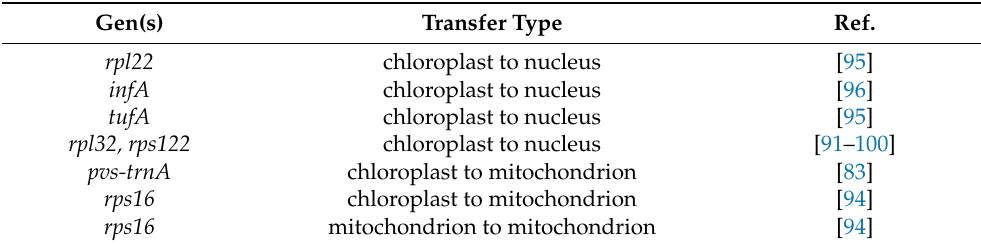
Table 1. Plastid genes in HGT involved in HGT in plants and type of the transfer. Gen(s) Transfer Type